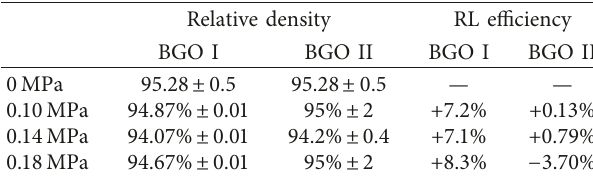
Table 1: Relative densities and RL efficiency for BGO I and II